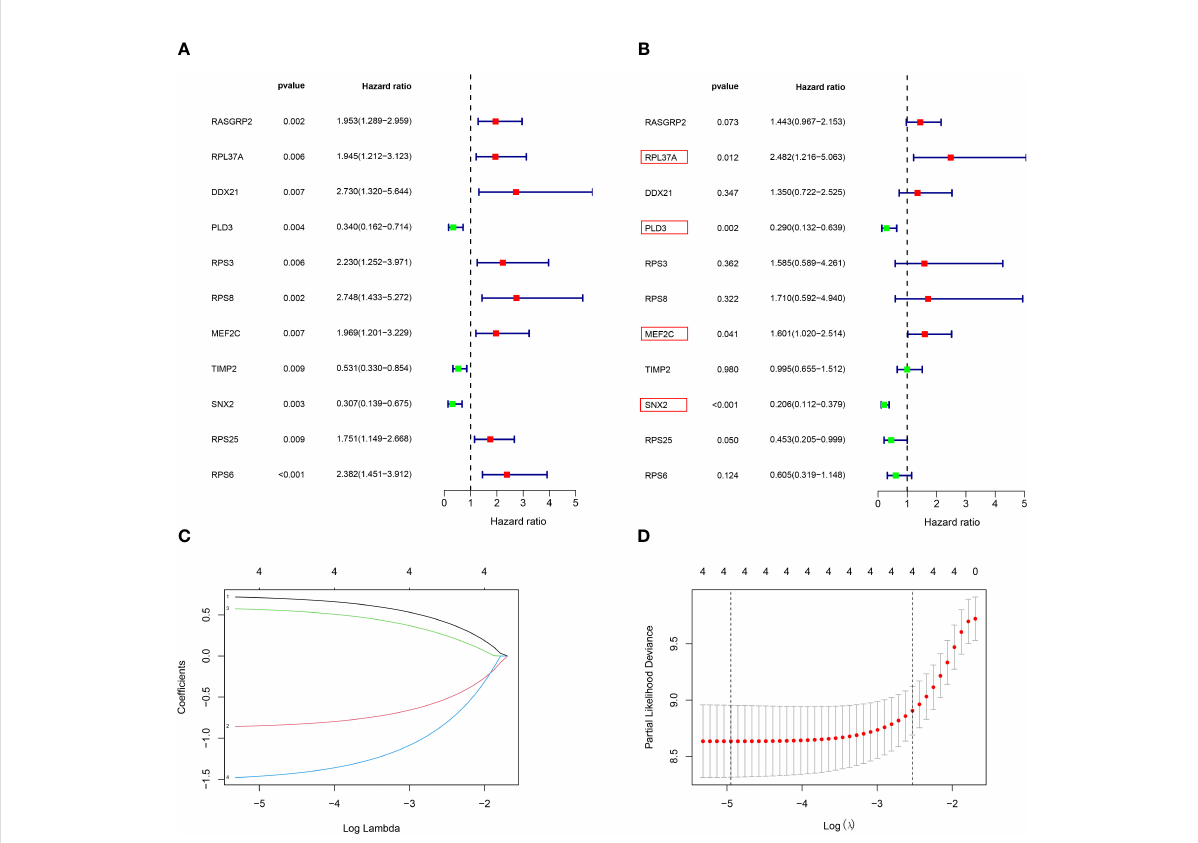
FIGURE 3 Construction of a risk ‐ scoring model for patients with osteosarcoma based on the TCGA database. (A, B) Univariate and multivariate Cox analysis demonstrated the correlation between B cell marker genes and prognosis. (C, D) LASSO regression analysis further screened the prognostic genes of B cell markers. (1: RPL37A, coef:0. 0.662; 2:PLD3, coef: -0.798; 3:MEF2C, coef: 0.510; 4:SNX2,